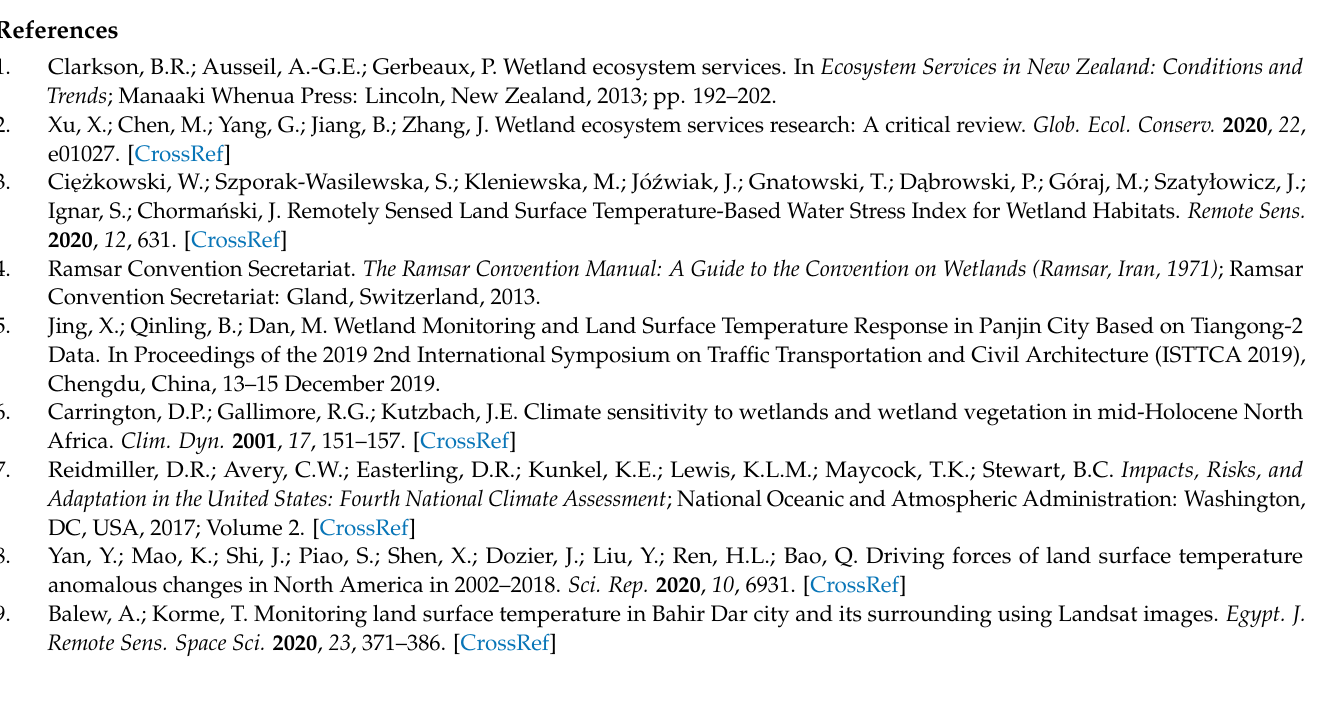
Figure S4: Linear regression between Landsat LST and Tair_obs values at nearby meteorological stations (Varzaneh and Hasanabad) on the selected 16 days. Figure S5: Tair_calc, Tair_obs and LST values at the meteorological stations on the selected 16